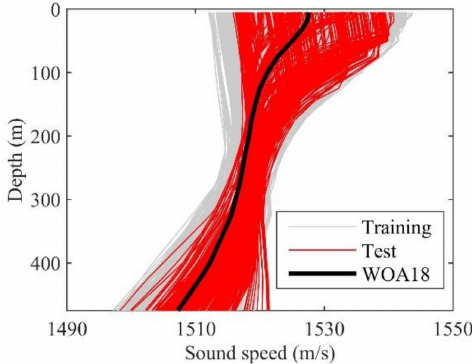
Figure 2. Profiles of training, testing, and the